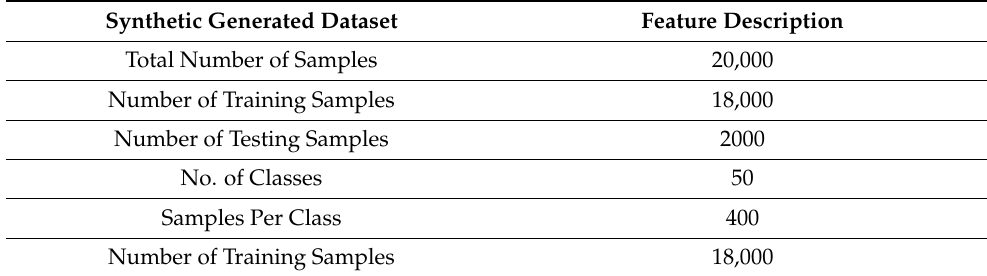
Figure 3. Some images of our synthetic dataset. Table 1. A summary of dataset feature description used in